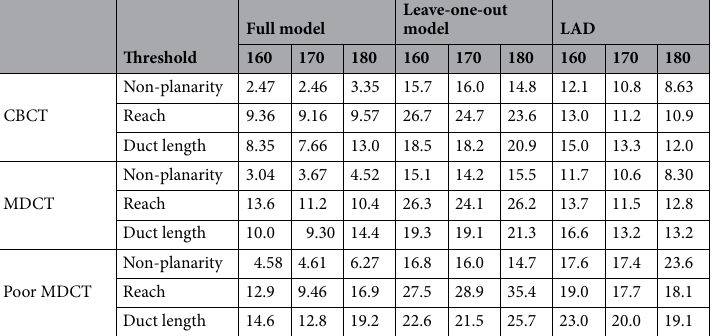
Table 1. Summary results for the 17 specimens without an implanted electrode. Average measurement errors are expressed as 100 × mean(absolute error)/gold-standard sample range.